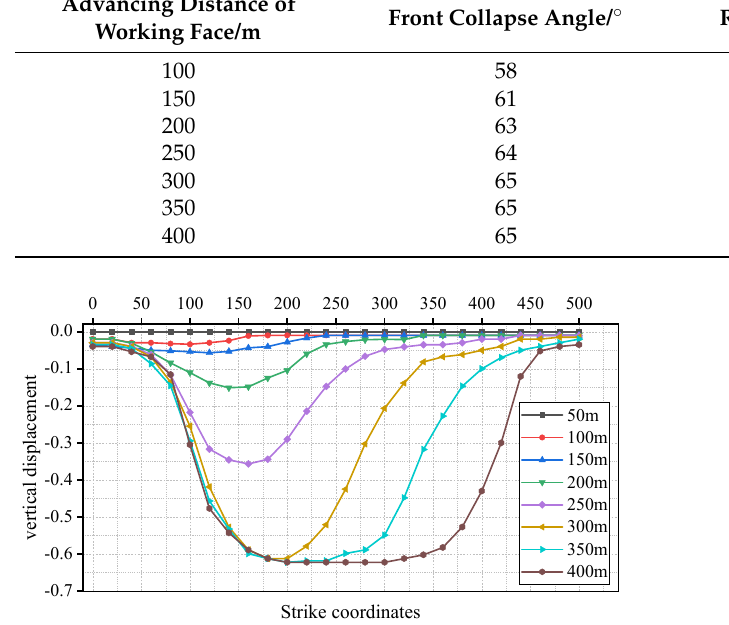
Figure 4. Surface vertical displacement for the karst aquifer without water.